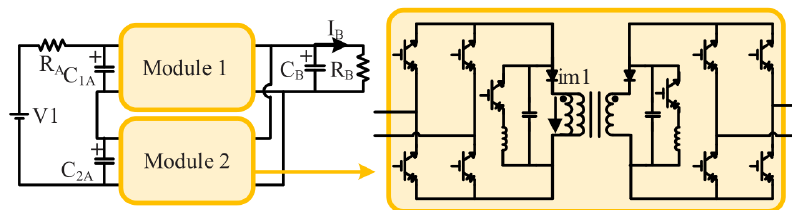
Figure 11. Modular S4T structure, configured for DC/DC operation